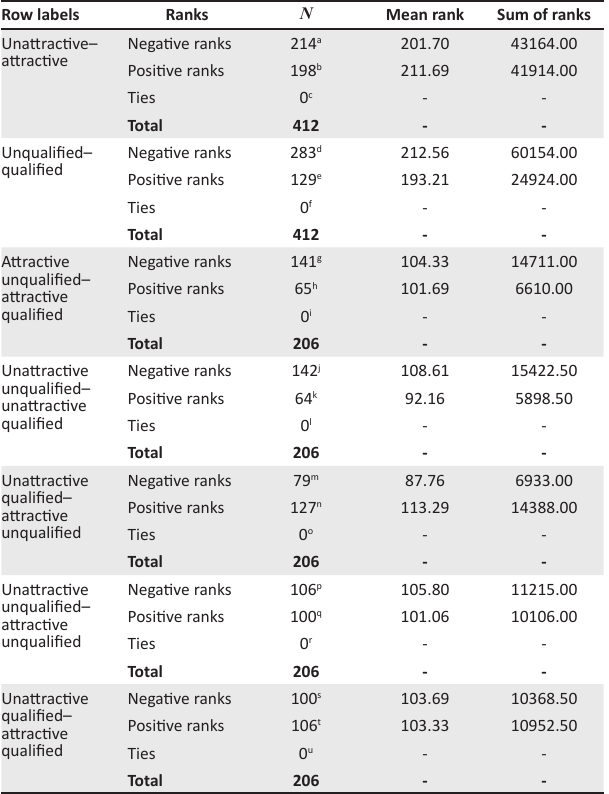
TABLE 5: Wilcoxon signed rank test results.